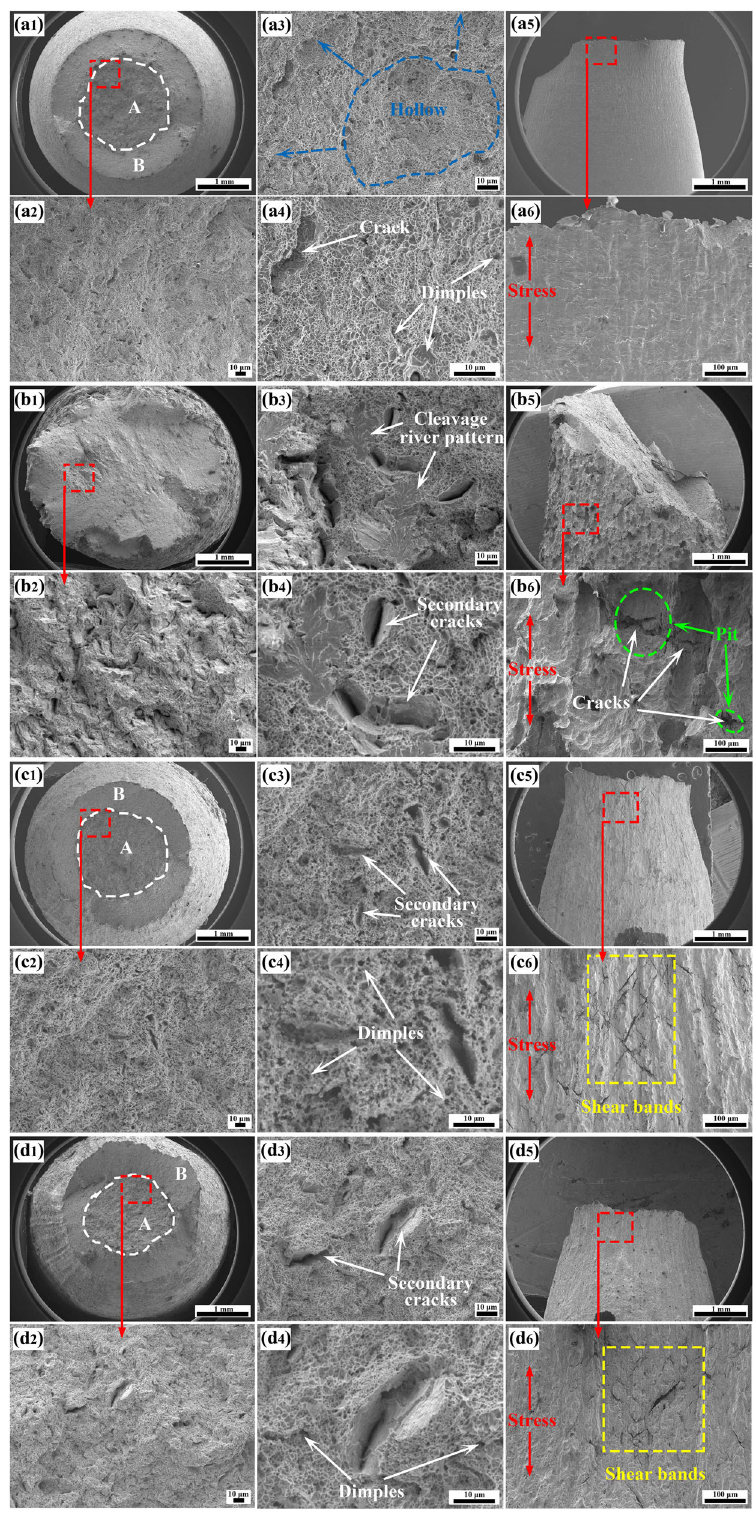
Fig. 11 SEM images of the fracture and side surfaces of the AISI 135 steel tensile samples after the SSRT. a1 – a6 blank control tensile sample and tensile samples placed at the b1 – b6 HTL, c1 – c6 MTL, and d1 – d6 LTL. The corrosion products on the sample surface were removed using a rust-cleaning solution prior to the side characterisation of the